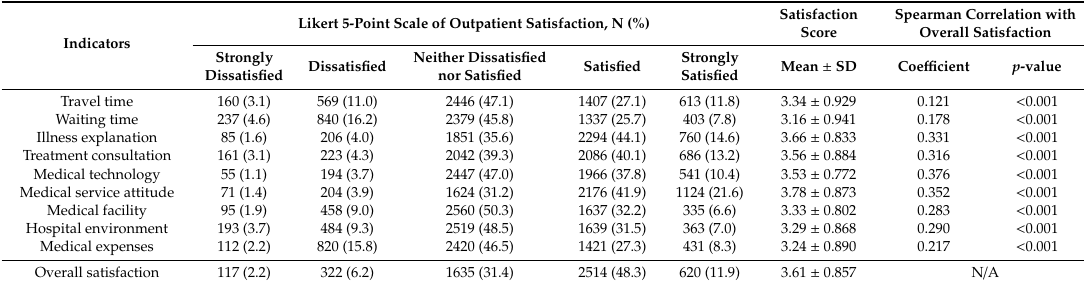
Table 2. Outpatient satisfaction with rural medical services.